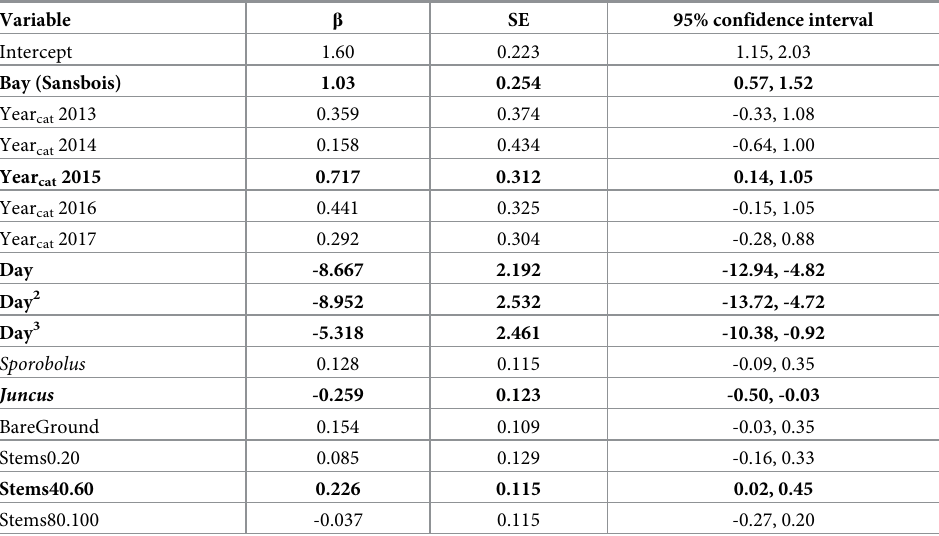
Parameter estimates whose 95% confidence intervals did not overlap 0 are in bold . See Table 1 for descriptions of